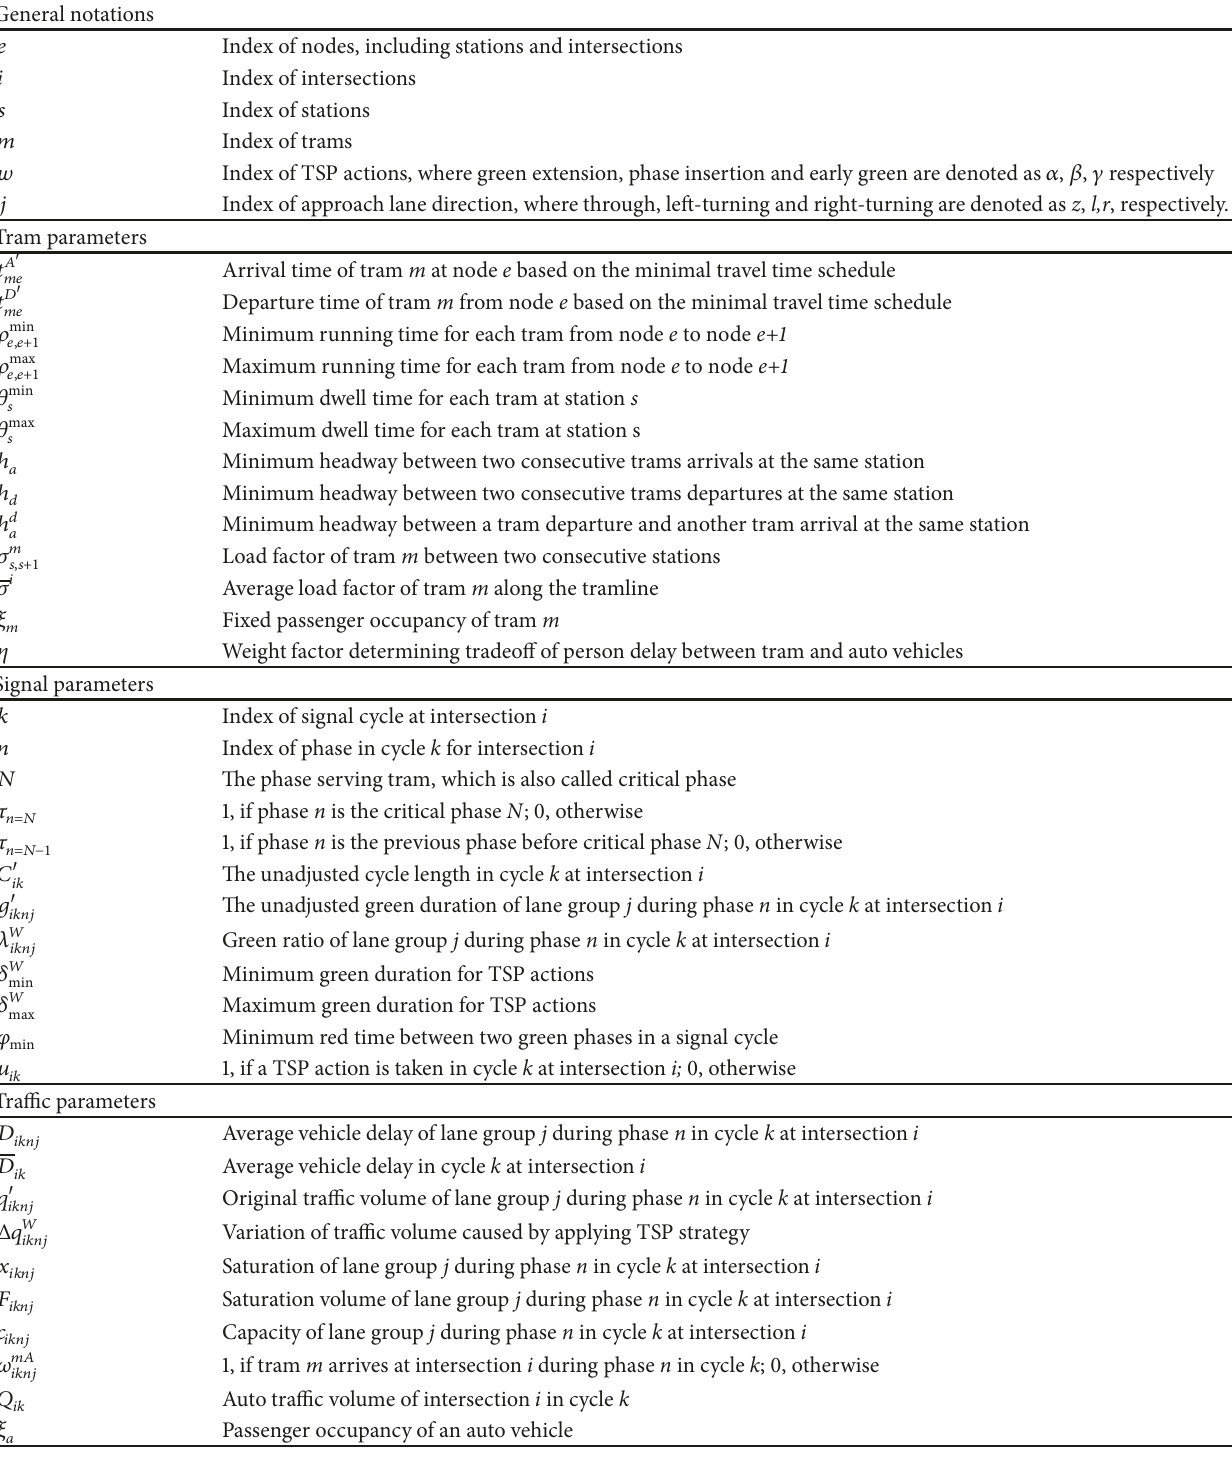
Table 2: Notations and